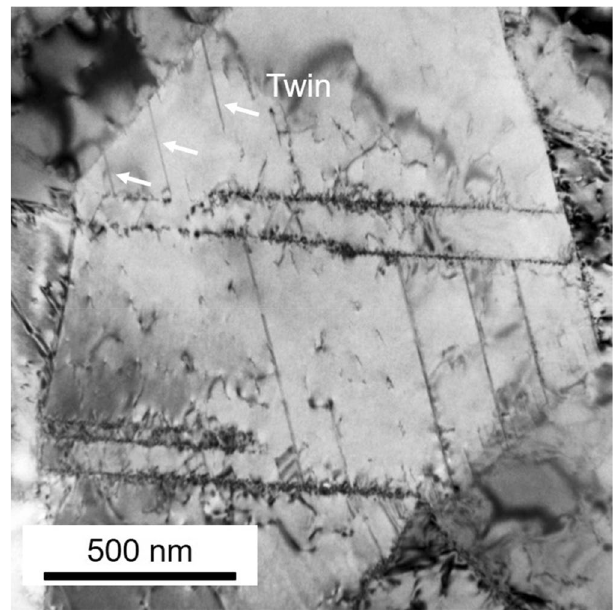
Figure 8. Bright field TEM image of the ultrafine-grained (UFG) specimen with the mean grain size of 0.79 μm tensile-deformed to an engineering strain of e =